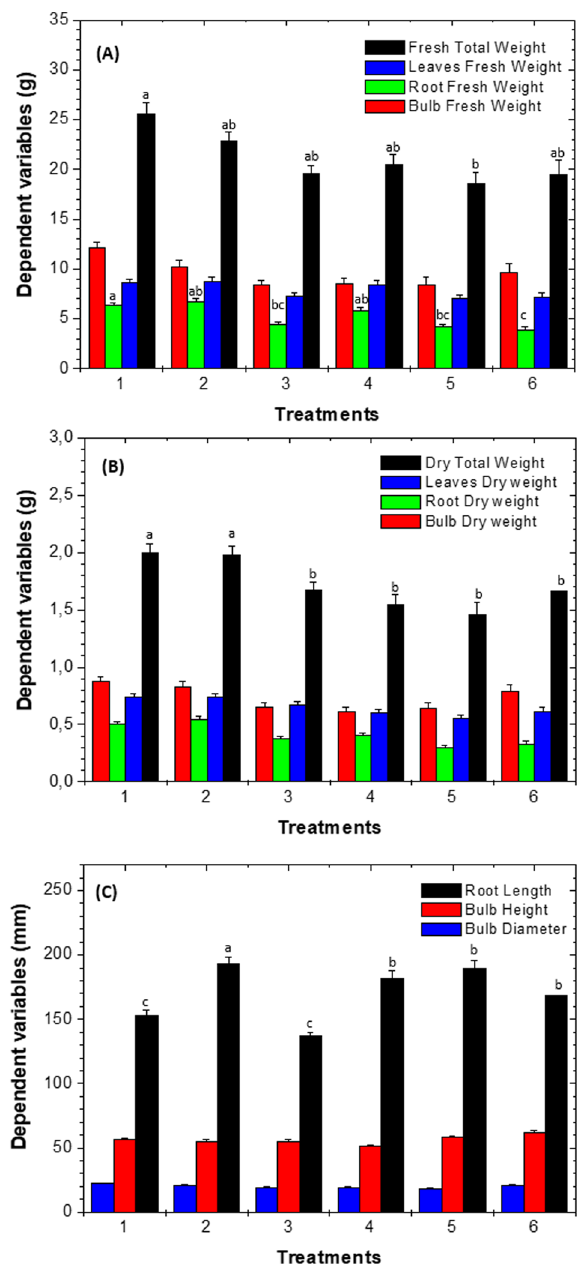
Figure 4. Effect of the biofertilizer on the growth of A. cepa L., in round plastics pots. ( A ) Variables for fresh- weights. ( B ) Variables for dry-weights. ( C ) Variables for the bulb. Figures letters represent the heterogeneous groups from Tukey’s test and indicate significant differences between treatments ( p < 0.05). T1: Abundagro + 5% Biochar + PSB; T2: Abundagro + 2% Biochar + PSB; T3: Abundagro + 5% Biochar alone; T4: Abundagro + 2% Biochar alone; T5: Abundagro; T6: